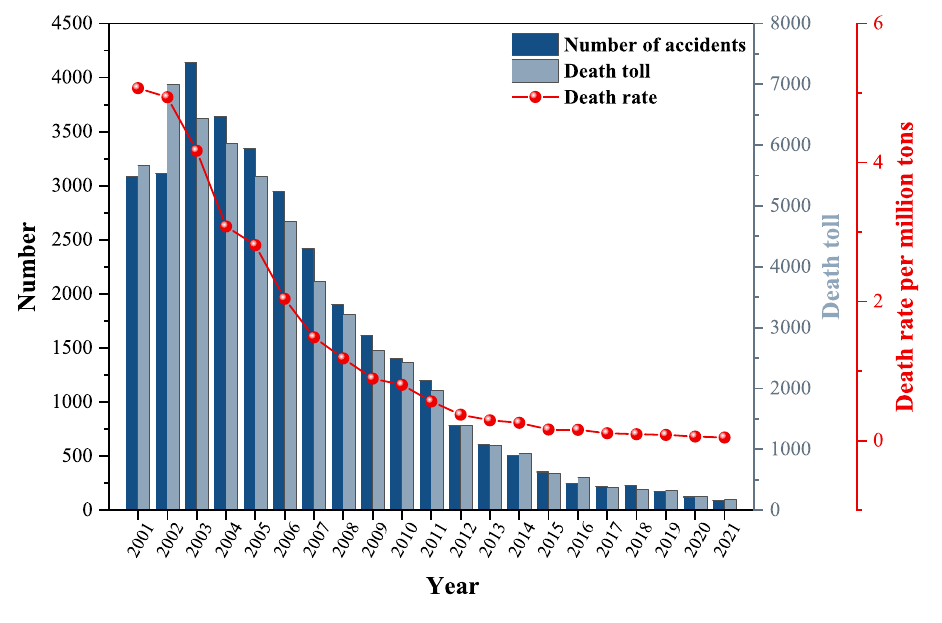
Fig. 4 Statistics of coal mine accidents from 2001 to 2021